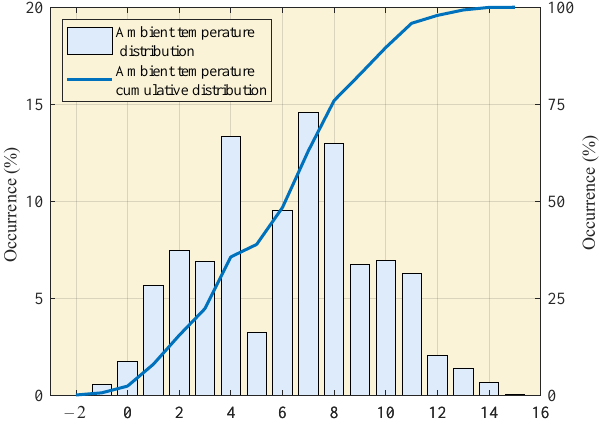
Figure 12. Distribution function and cumulative distribution function of ambient temperature for 7 days.